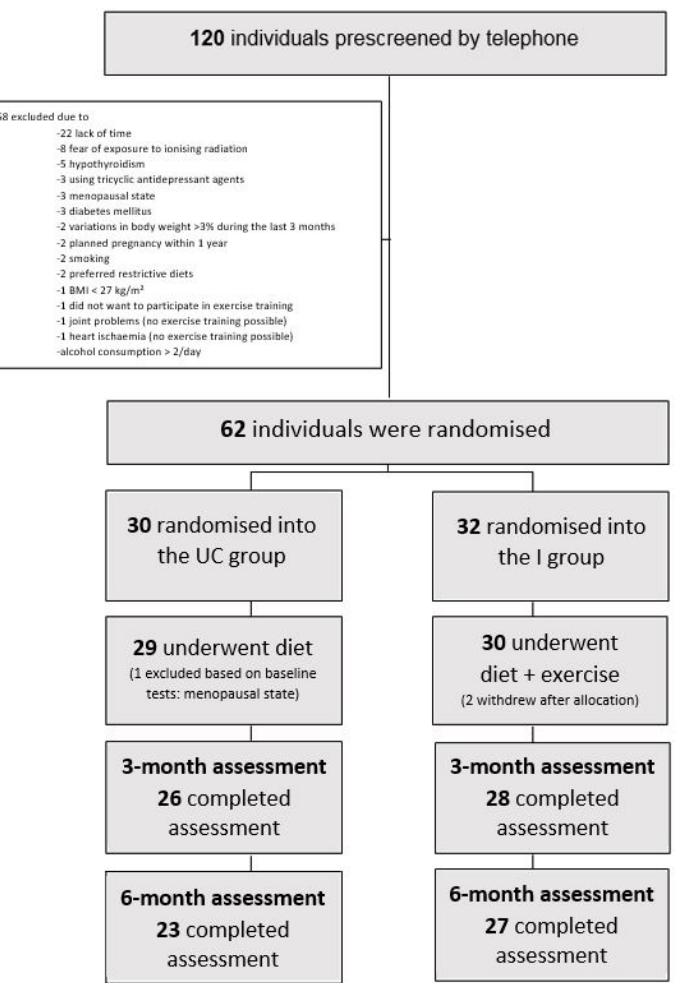
Figure 1. Flow chart of the study participants.